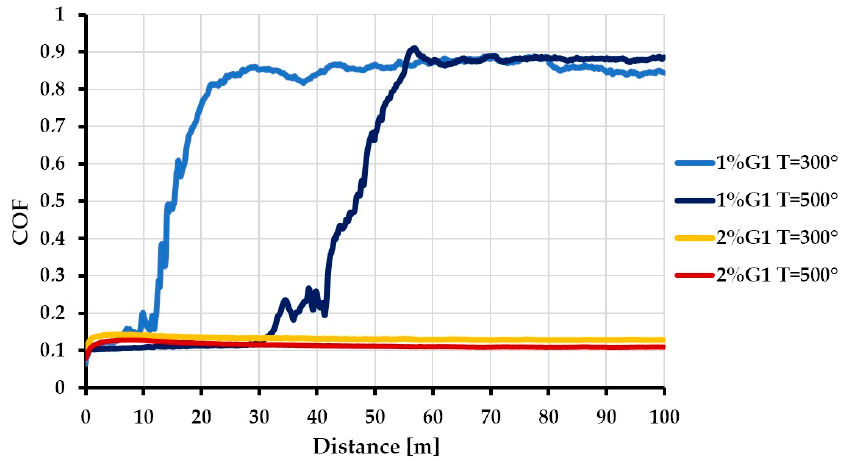
Figure 7. The ball-on-disc test of Al 2 O 3 + G1 graphene coatings heat treated at 300 °C and 500 °C.